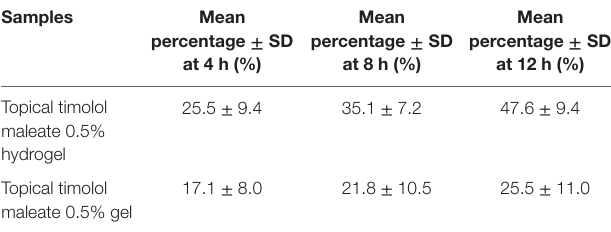
TaBle 4 | Permeation rate (%) of topical timolol maleate 0.5% hydrogel or gel. samples